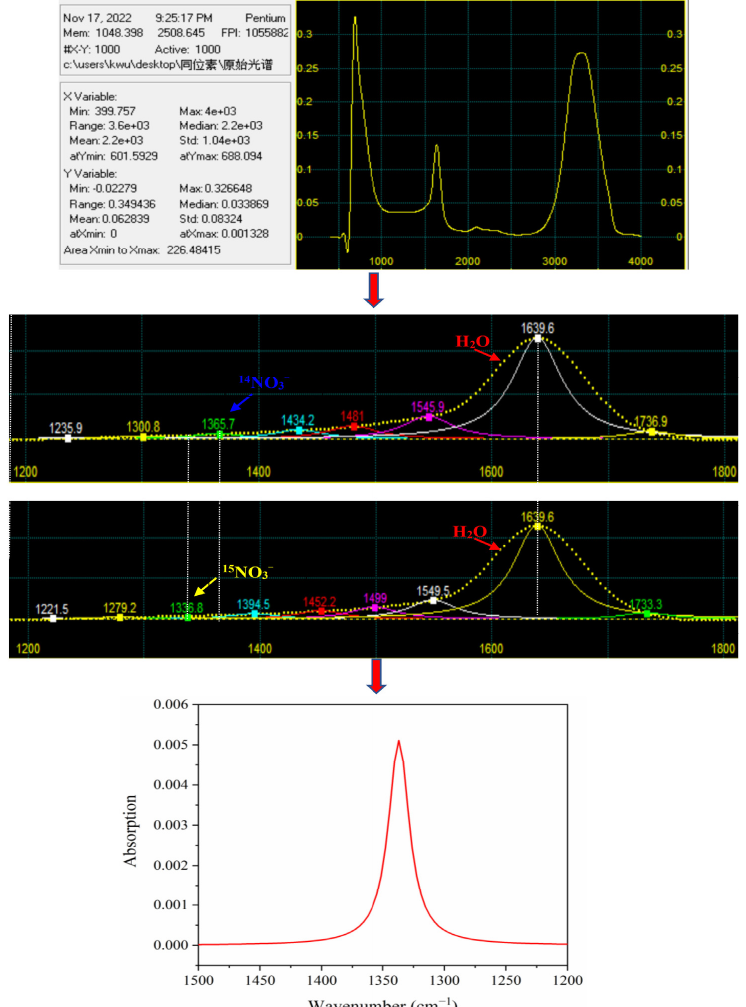
Figure 6. The process of spectra deconvolution.